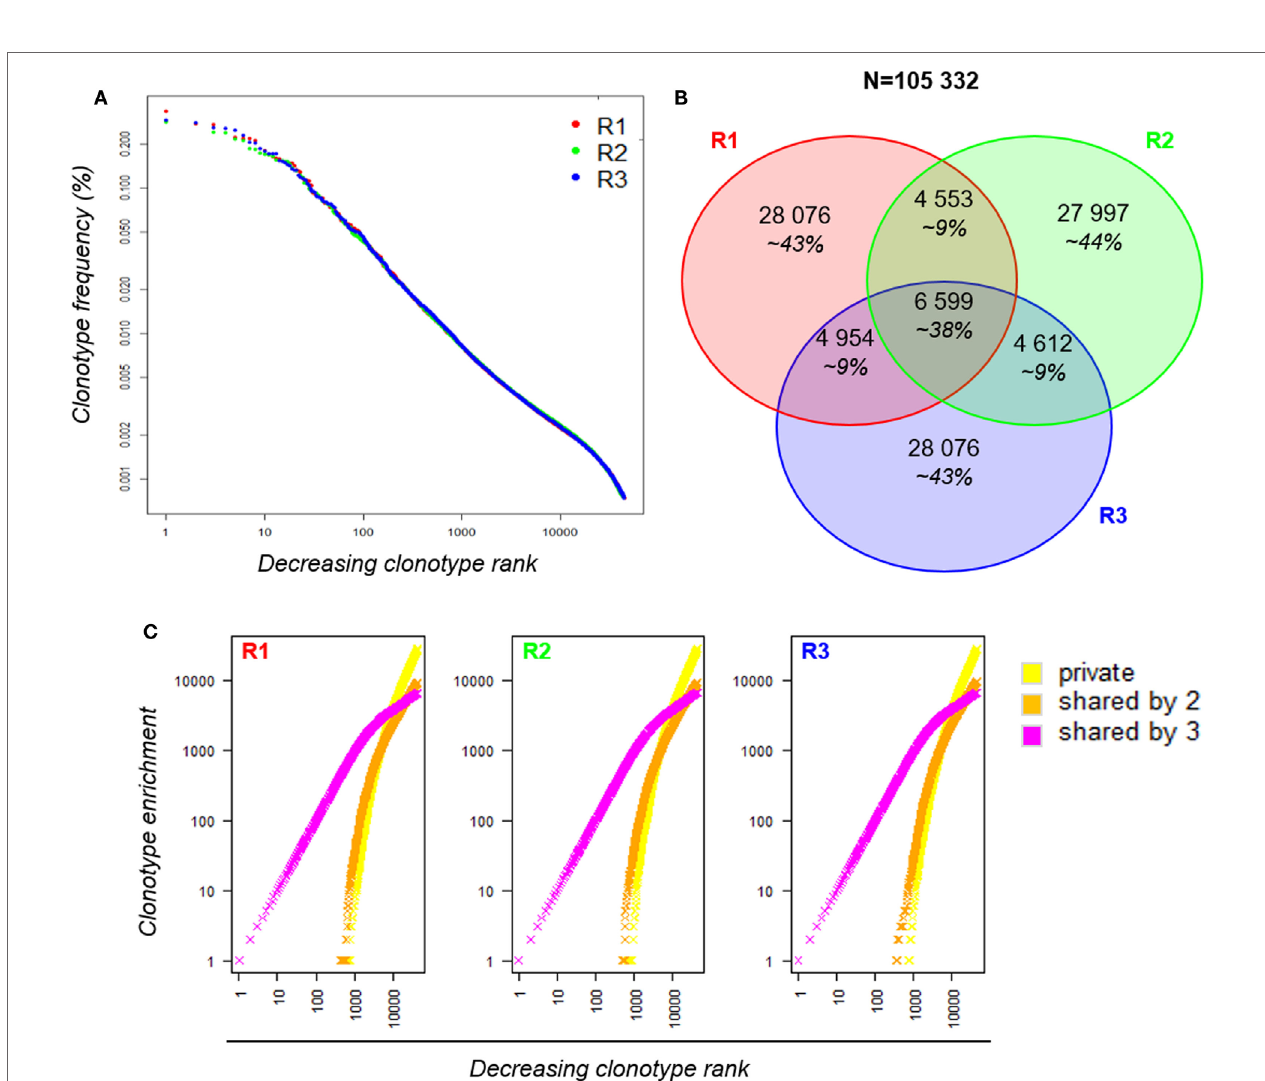
FigUre 3 | Robustness of a RepSeq experiment. (a) Clonotype distribution of the three replicates within each dataset. Informative clonotypes were ranked decreasingly according to their abundance and their frequency was plotted. The x -axis is log-scaled. (B) Venn diagram between the three replicates. Out of the 105,332 clonotypes observed in total, only 6,599 are shared by the three replicates; their cumulative frequency covers about 38% of each dataset. (c) Spectrum of unshared (yellow) and shared (by two in orange and by three in magenta) clonotypes in each replicate. Within each dataset, clonotypes were ranked according to their counts from the most to the least predominant (decreasing clonotype rank). Since clonotypes are labeled according to their sharing status, the clonotype enrichment ( y -axis) of each sharing group is incremented ( + 1) when a corresponding clonotype is found in the ranked